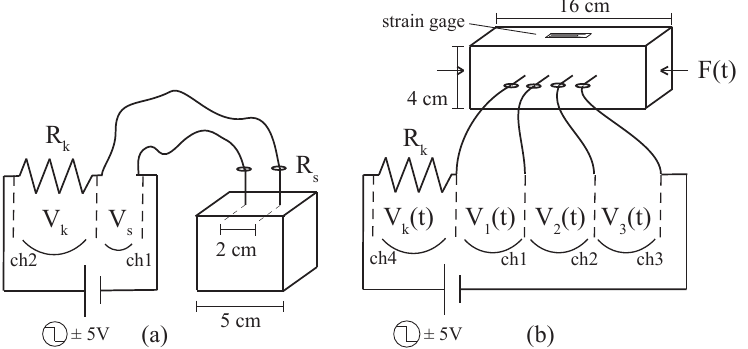
Figure 3. Experimental setups for electrical measurements on smart earth samples: ( a ) cubes for per- colation investigation; ( b ) small-scale beams for electromechanical tests and piezoresistivity